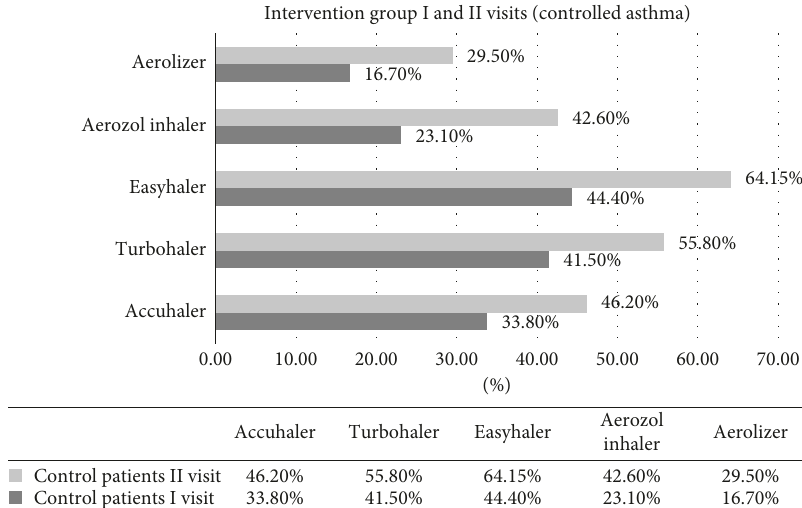
Figure 1: Asthma control by the inhaler type.